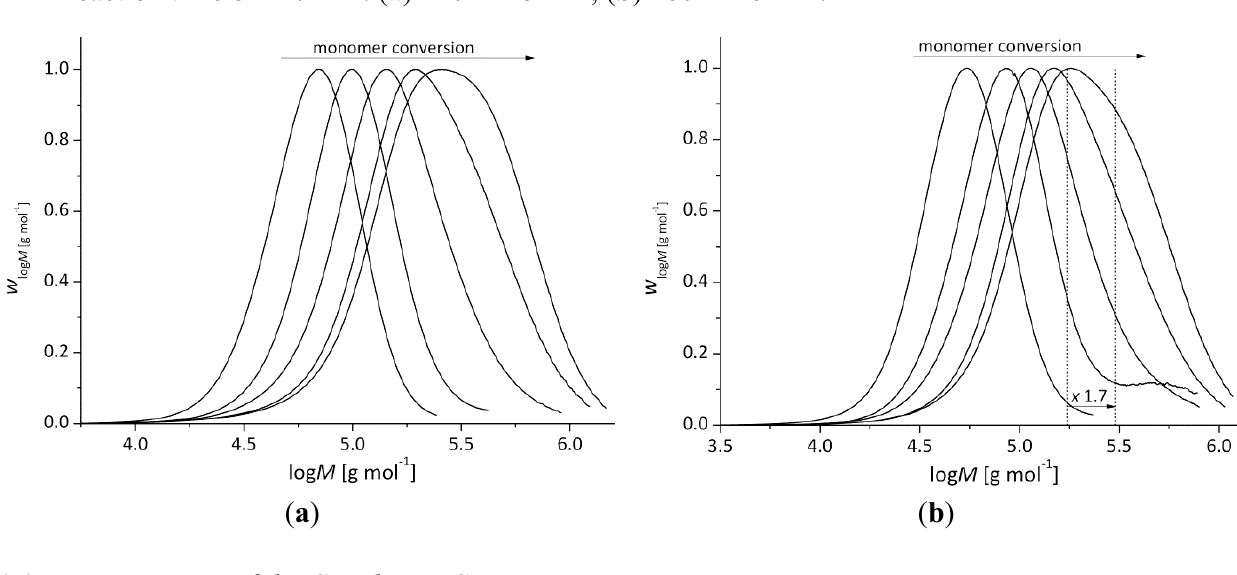
Figure 12. Corrected UV-SEC-curves of the copolymerizations of NIPAm with 1.1 up to